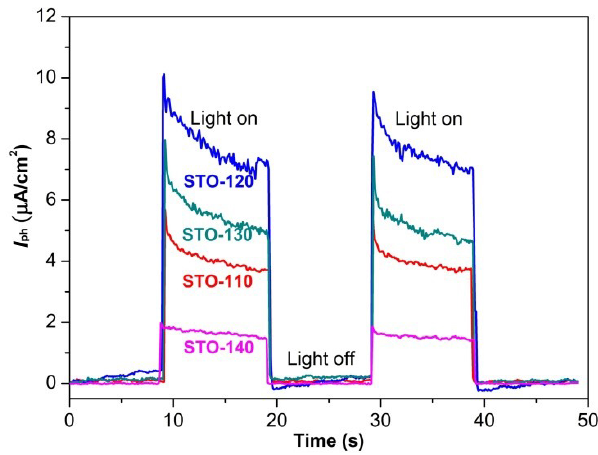
Fig. 6 Photocurrent profiles recorded for the different samples at a bias potential of +0.20 V (vs. Ag/AgCl) under UV light